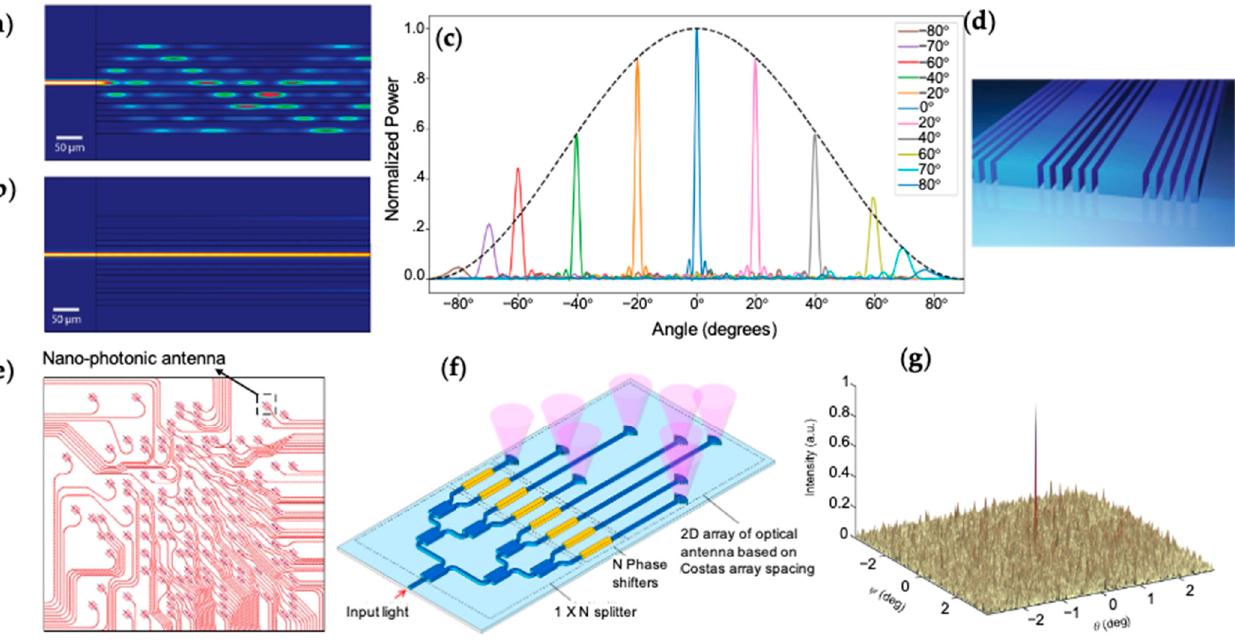
Figure 4. ( a ) Simulation of light propagation in an array of waveguides with equal width of 400 nm on λ /2 pitch [41]. ( b ) Simulation of the phase-mismatched waveguide array with sequentially varying widths of 300, 350, and 400 nm [41]. ( c ) Measured far-field optical power versus output angle over a 180° FOV. Reprinted with permission from [41]. Copyright © 2022, Phare et al. ( d ) Control of the evanescent field by all-dielectric metamaterial between waveguides [42]. Copyright © 2022, Jahani et al. ( e ) A non-uniform 2D sparse OPA with 128 elements. © 2022 IEEE. Reprinted with permission, from [35]. ( f , g ) Schematic of a 2D Costas array and the measured far-field beam profile. Adapted with permission from [32] © The Optical Society.